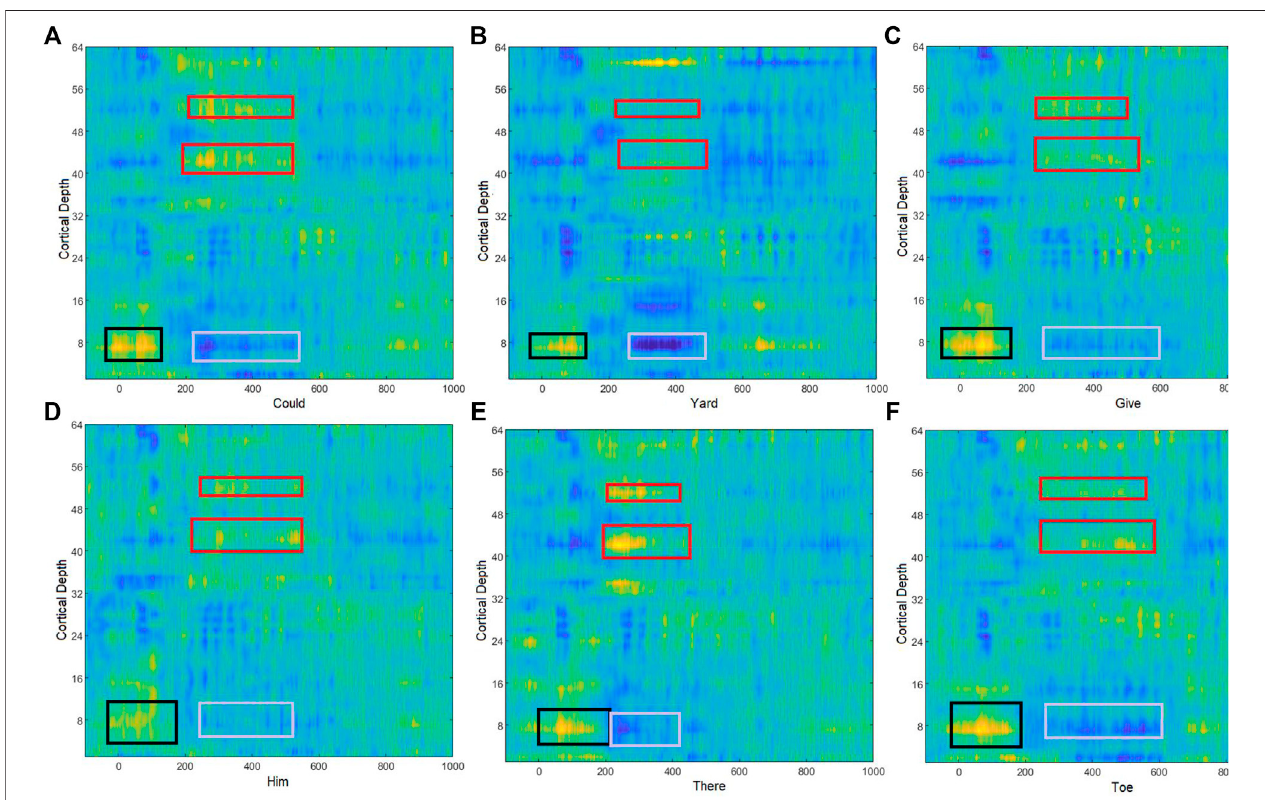
FIGURE3| Brain activity during the imagined words (A) could, (B) yard, (C) give, (D) him, (E) there, and (F) toe.Black boxesrepresenttheearlypositive de fl ection in theleft temporal region, which representsthespeechcomprehension. Red boxesrepresentthe higher positive de fl ection at the righttemporal regionduring imagined speech production where gray boxes represent corresponding negative de fl ection in the EEG